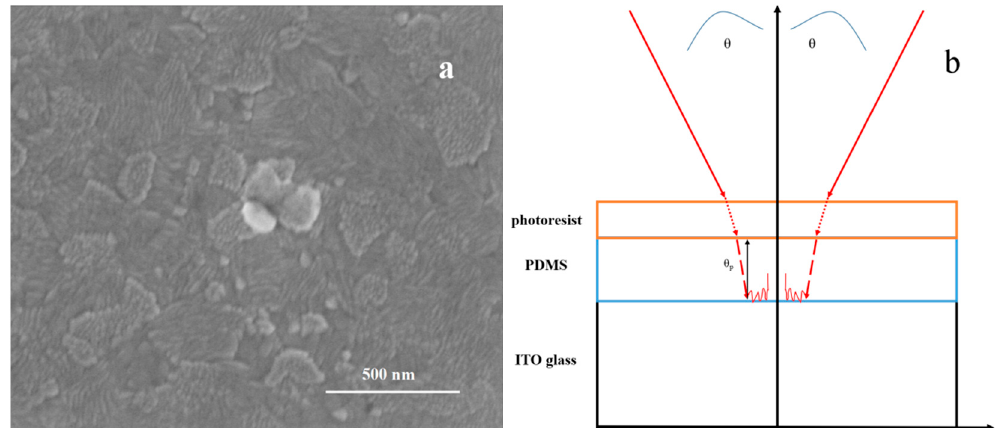
Figure 3. ( a ) Topography of ITO glass under SEM, the pattern showed the surface roughness of the ITO surface. ( b ) Schematic of the wave vectors for double beam laser interference lithography on ITO glass coated with PDMS. Because of the absorption and surface diffuse reflection of transparent ITO glass, the intensity of the beam reflected back to the photoresist is actually very small.